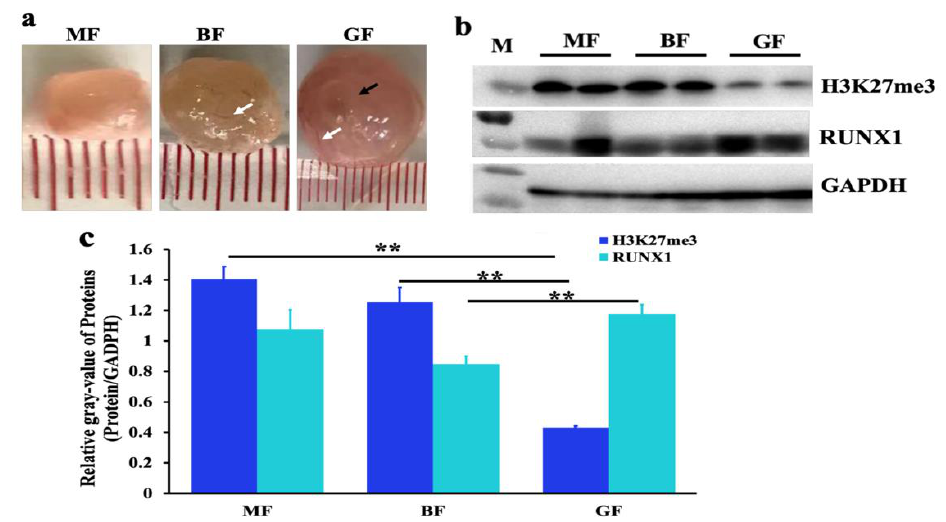
Figure 1. H3K27me3 and RUNX1 in di ff erent stages of follicles. ( a ) Follicles used for Western blotting (WB). MF, medium-sized follicle; BF, big-sized follicle; GF, graafian follicle. The white arrow indicates the blood vessels. The black arrow indicates the obvious ovulation hole in the mature follicle. ( b , c ) The relative gray values of H3K27me3 and RUNX1 in medium-sized follicles, big-sized follicles, and graafian follicles, normalized using the H3K27me3, RUNX2, and GAPDH gray values, respectively. The ** indicates p < 0.01.